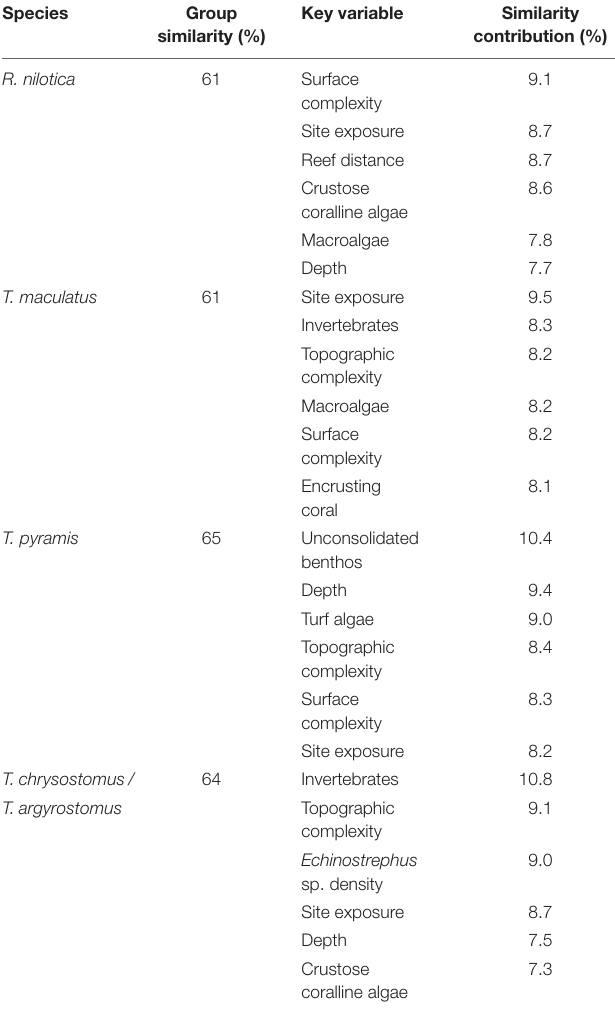
TABLE 4 | Similarity percentage routine (SIMPER) on the habitat variables relating to the density of each gastropod species, displaying the key habitat variables that altogether contributed at least 50% to habitat similarity among replicates within each species. Species Group Key variable Similarity similarity (%) contribution